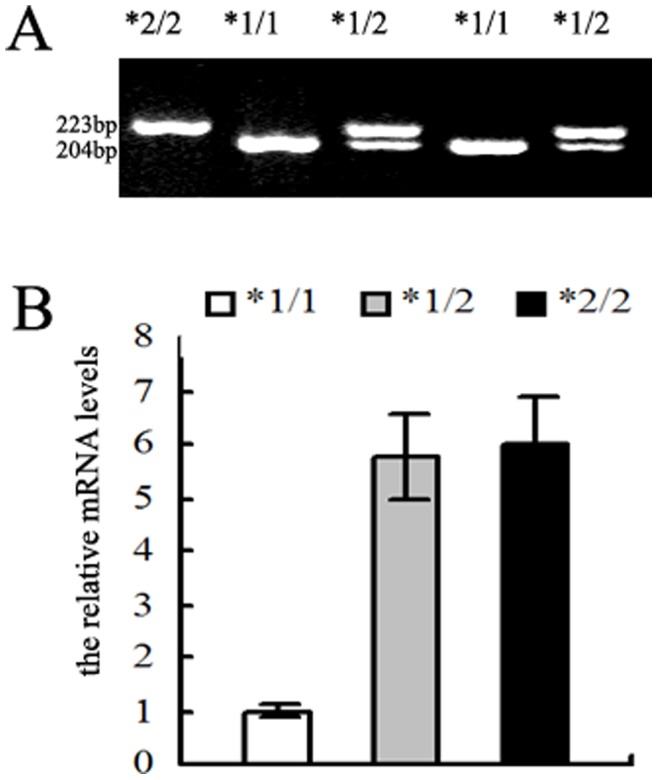
Genotype and expression of LAPTM4B protein in breast cancer tissues.(A) The genotype of LAPTM4B in representive breast cancer tissues. Lane 2, 4: *1/1 genotype; lane 3, 5: *1/2 genotypes; and lane 1: *2/2 genotype. (B) The mRNA levels of LAPTM4B in breast cancer tissues. The data represent one of three independent experiments.